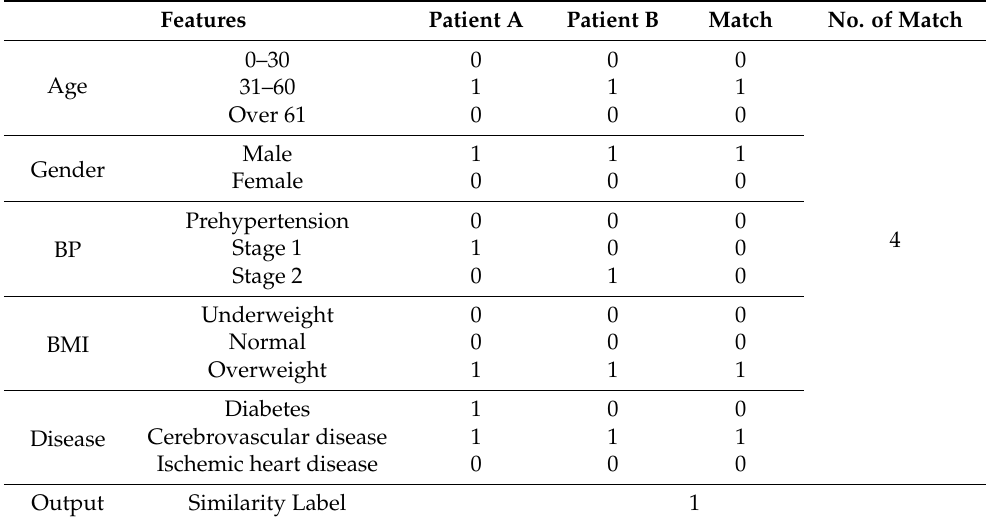
Table 2. Example of similarity